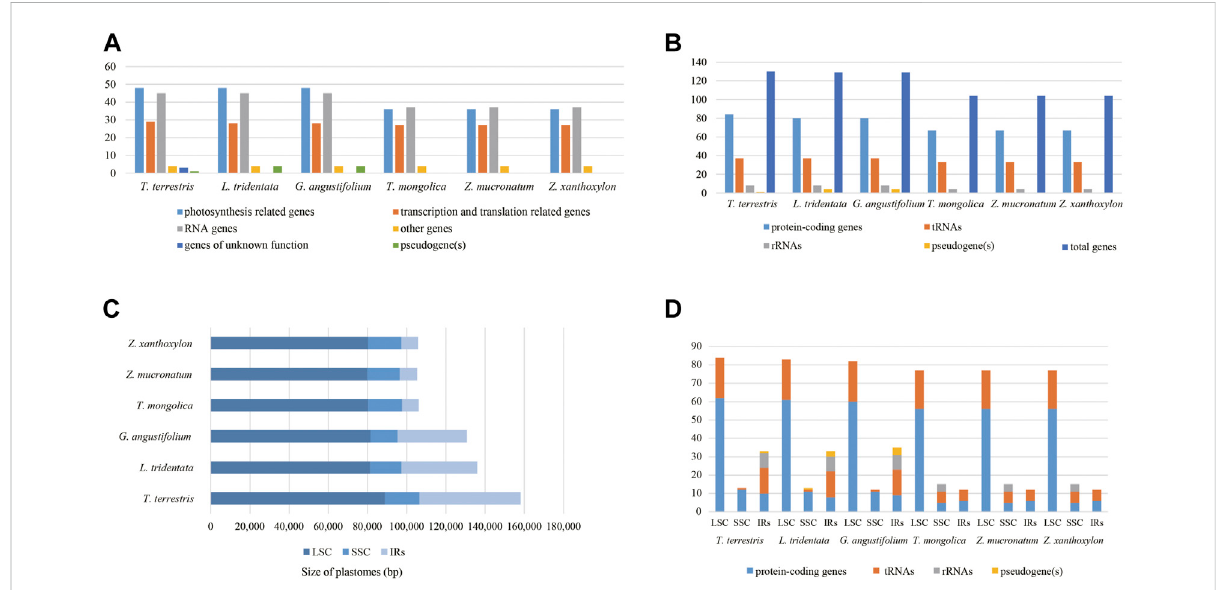
FIGURE 1 Characteristics of Zygophyllaceae chloroplast genomes. (A) Number of different functional categories of genes. (B) Number of genes. (C) Size of cp genomes. (D) Number of genes located in different